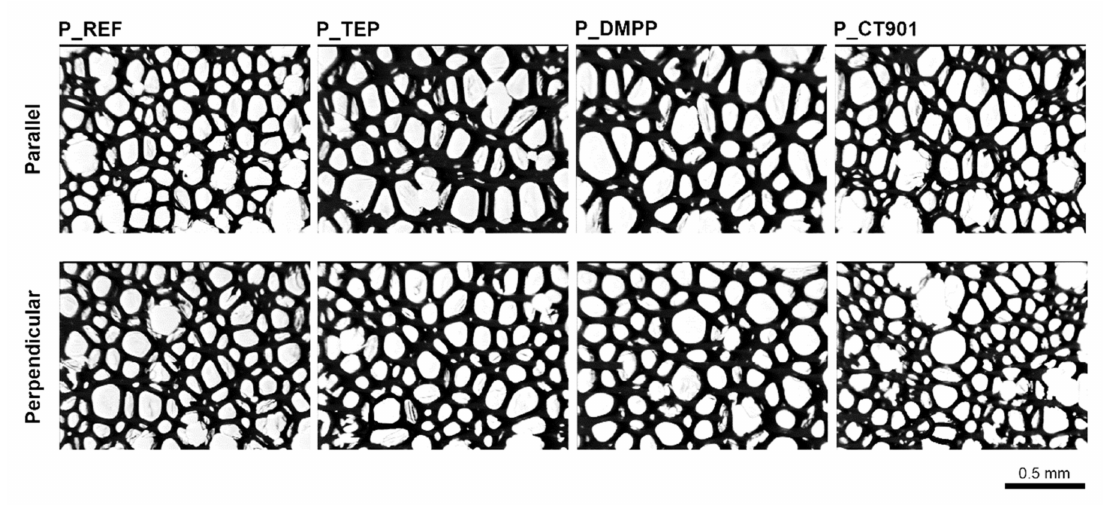
Figure 4. Microphotographs of the cellular structure of PUR foams without